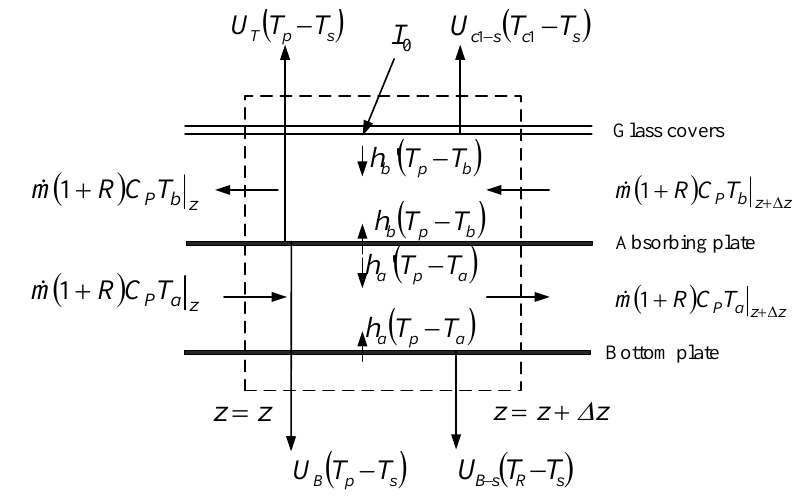
Figure 2. The energy balance on energy flow within a finite fluid